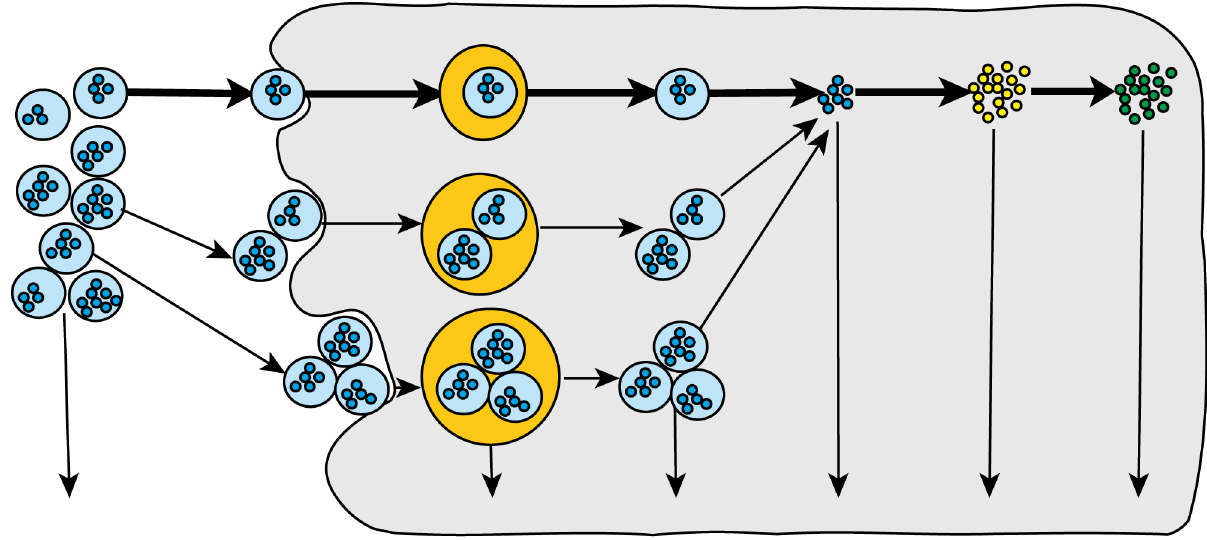
Figure 2. Diagram of the multiple-lipoplex transfection model. This includes the same processes as in the streamlined model, except that here the clathrin-coated pits and the endosomes can contain multiple